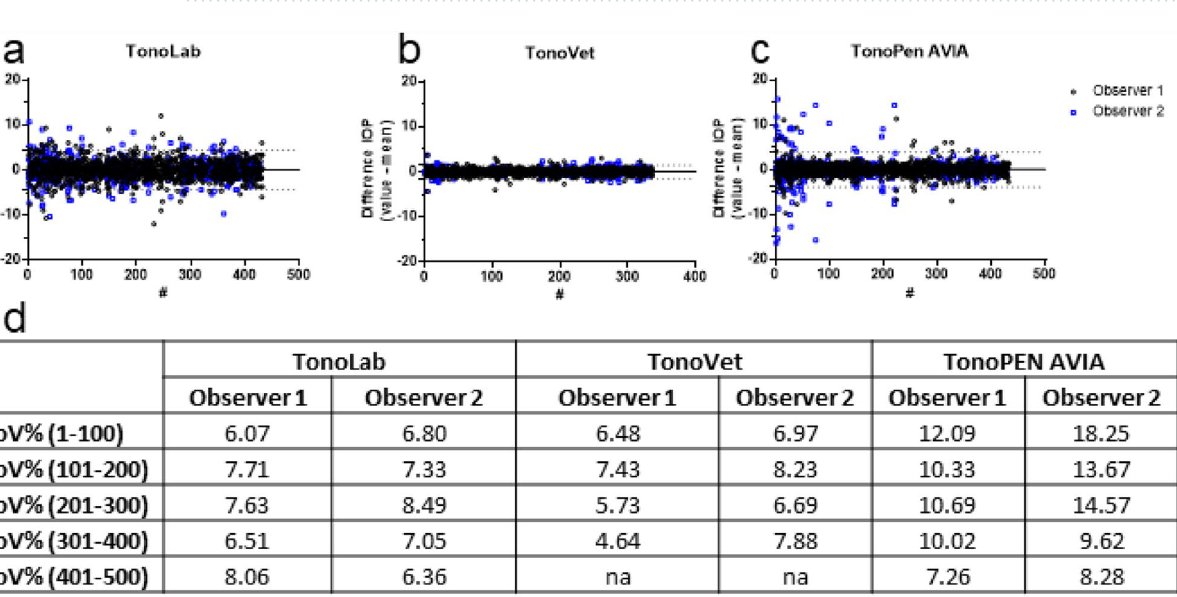
Figure 3. Repeatability of IOP measurements plotted over time. Intra-observer difference in IOP for the ( a ) TonoLab, ( b ) TonoVet, and ( c ) TonoPEN AVIA. ( a – c ) Dotted lines represent 1.96 times the SD (95% confidence interval (CI)). ( d ) Table summarizing the coefficient of variation (CoV) per range of measurements (per 100). Measurement #1 is the first measurement taken with the device, whereas #400 is the 400th measurement. na; not